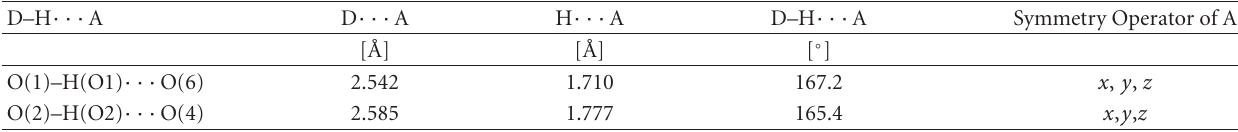
Table 5: Dimensions of the hydrogen bonds in complex 2 . a